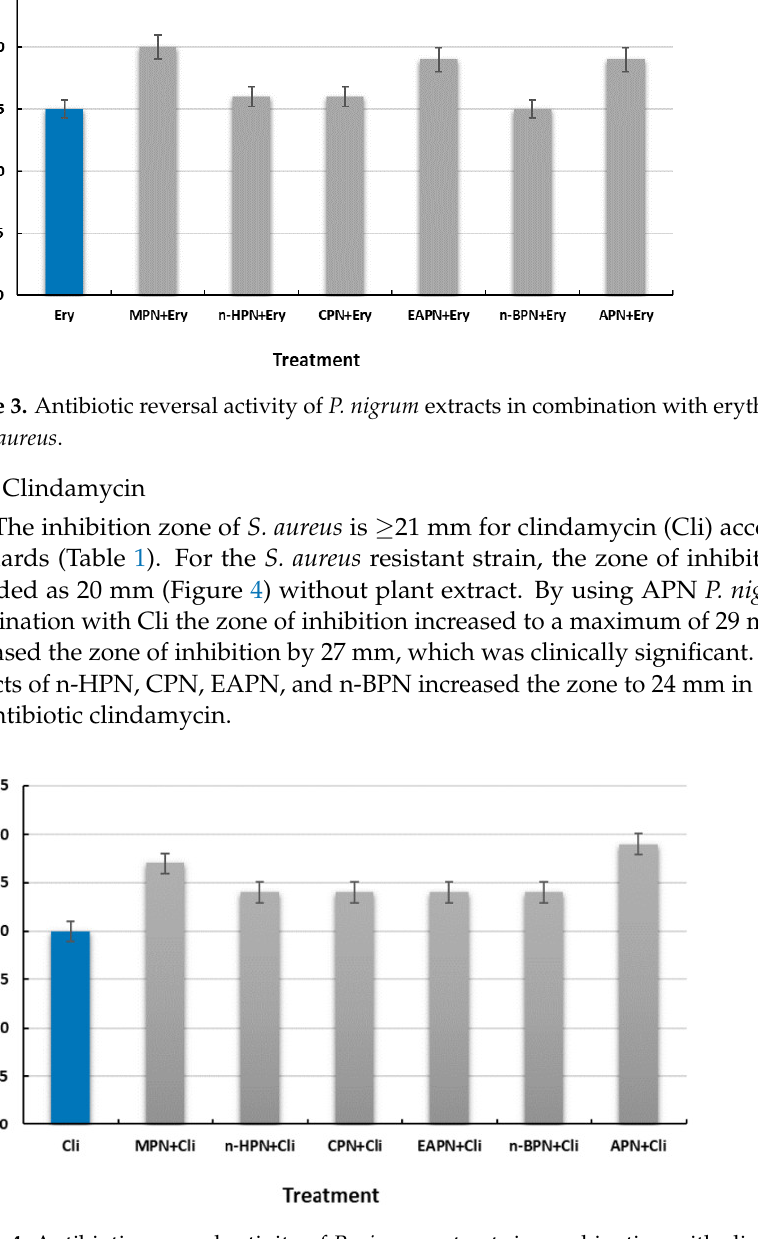
Figure 4. Antibiotic reversal activity of P. nigrum extracts in combination with clindamycin ( 10 μg) for S. aureus.